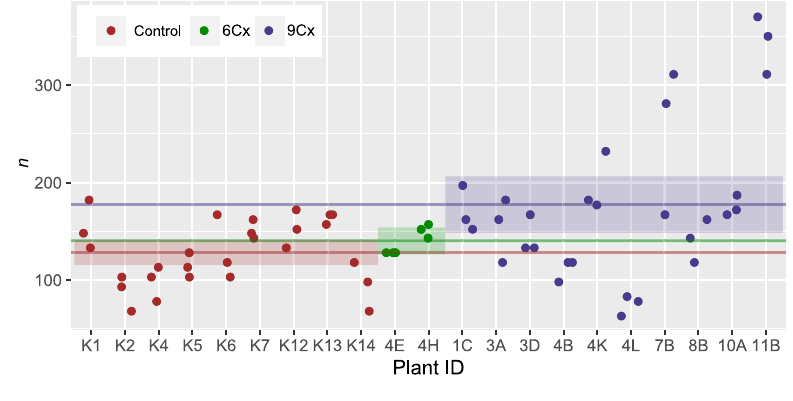
Figure 4 Stomatal density in seedlings (6Cx control) and endosperm-derived plants (6Cx and 9Cx regenerants). n = number of stomata per mm 2 ; horizontal lines accompanied by semitransparent bands in appropriate colors show mean values and 95% confidence intervals for the measurement